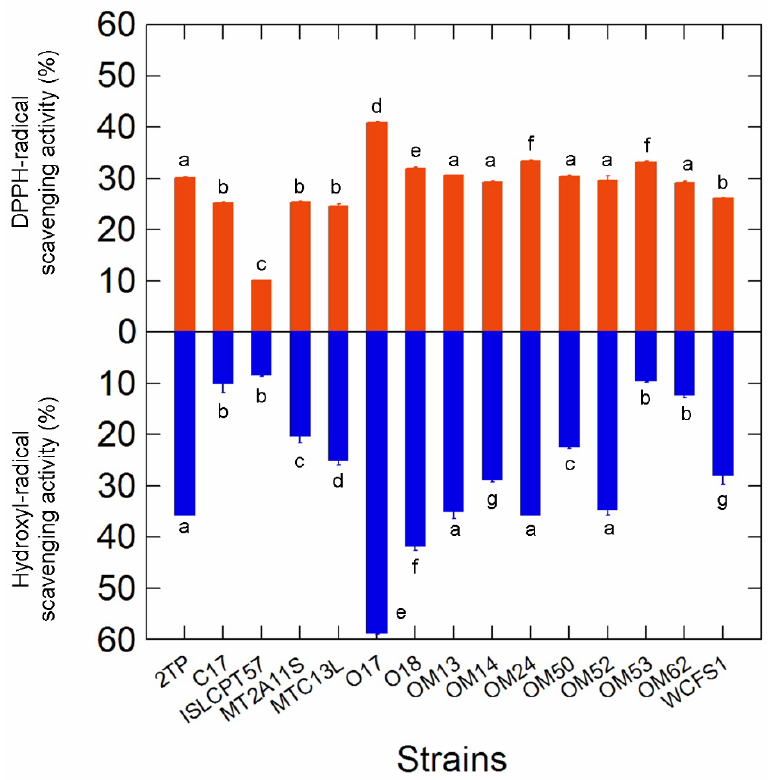
Figure 3. DPPH and hydroxyl radical scavenging activities in the 15 selected Lactiplantibacillus strains. Letters on plot bars indicate significant differences (Tukey ′ s HSD, p < 0.01) in scavenging activity within strains.